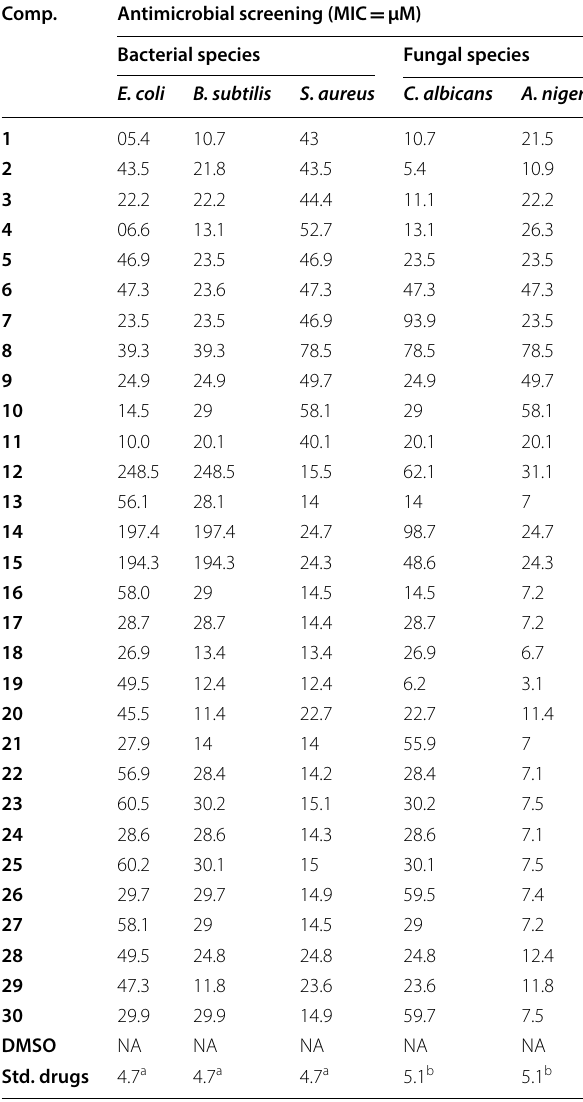
NA no activity, DMSO dimethyl sulphoxide Std. drugs: a Norfloxacin, b Fluconazole